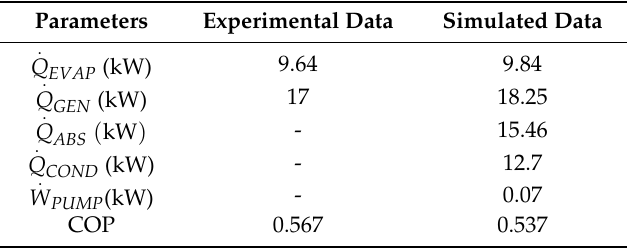
Table 4. Comparison of heat duties and coe ffi cient of performance (COP) between experimental and simulation results at the ambient temperature of 35 ◦